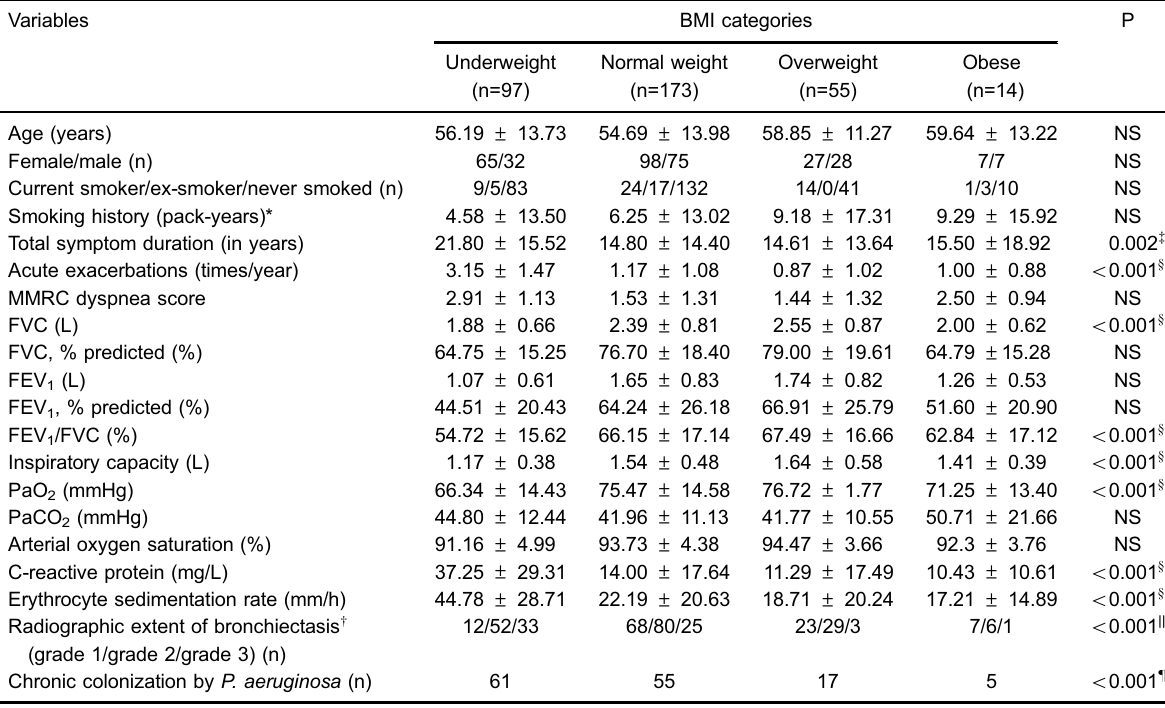
Table 3. Comparison of demographic data and clinical variables among the four